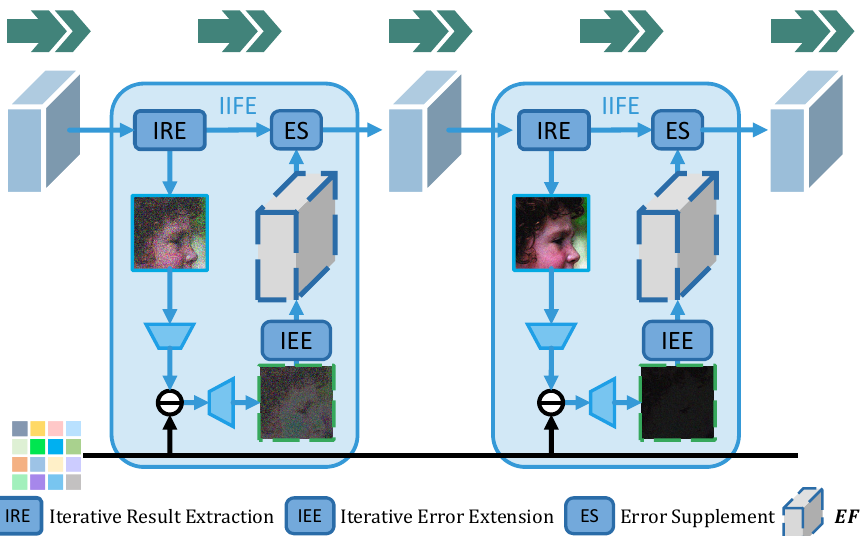
Figure 7. IIFE module. IRE, IEE, and ES modules, marked with dark blue boxes, aim to extract the CR i from IF i , encode and extend the EI i to output abundant information of Error Features EF i , and supplement the main branch IF i by EF i , respectively. Additionally, IF i and EF i are represented as blue and gray cubes, respectively. Compared with Figure 6, there is no forced waste and compression of the information flow marked by green arrows, thus achieving a smoother